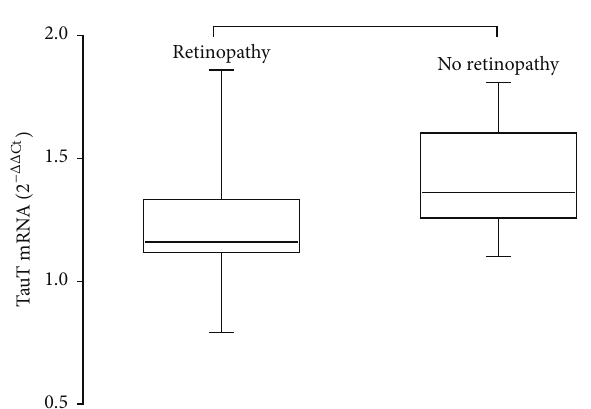
Figure 4: Box and whisker plots of TauT mRNA gene expression in mononuclear peripheral blood cells of type 1 diabetes with or without